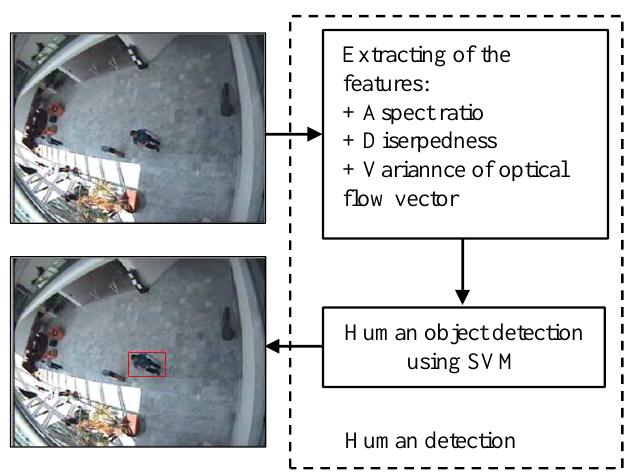
Figure 5: The process of objects detection using SVM and features based on shape and motion